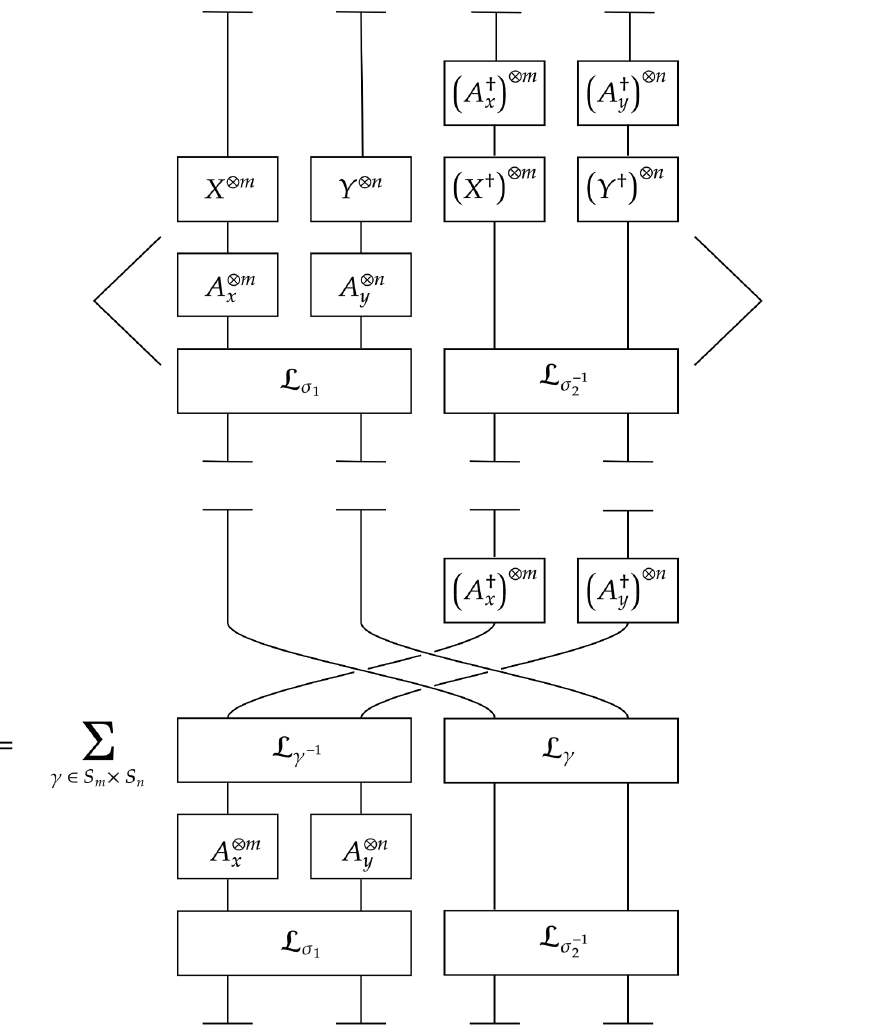
Figure 6 . The diagrammatic representation of the general two-matrix correlator with classical matrix fields. The presence of the two index swaps in the lower diagram is to account for the two classical matrices A x and A y , appearing after applying Wick’s